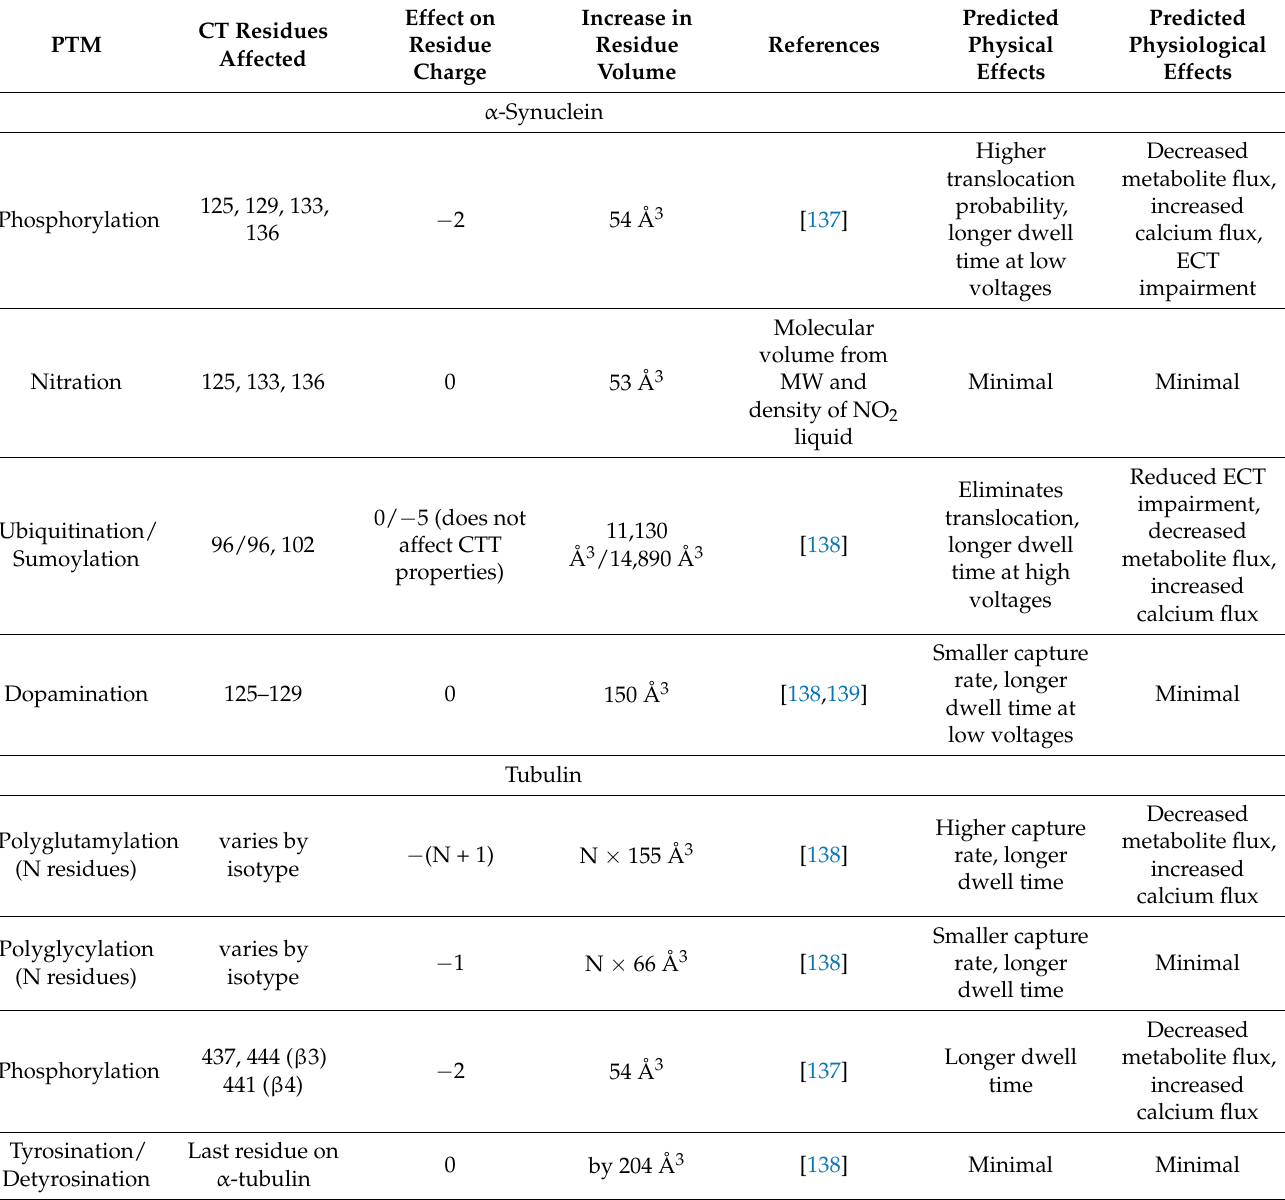
Table 2. Post-translational modifications to polyanionic C-terminal domains of α Syn and tubulin. Predicted physiological effects are relative to unmodified α Syn or tubulin. Adapted with permission from Hoogerheide et al., Nanoscale . (2020). Reproduced by permission of The Royal Society of